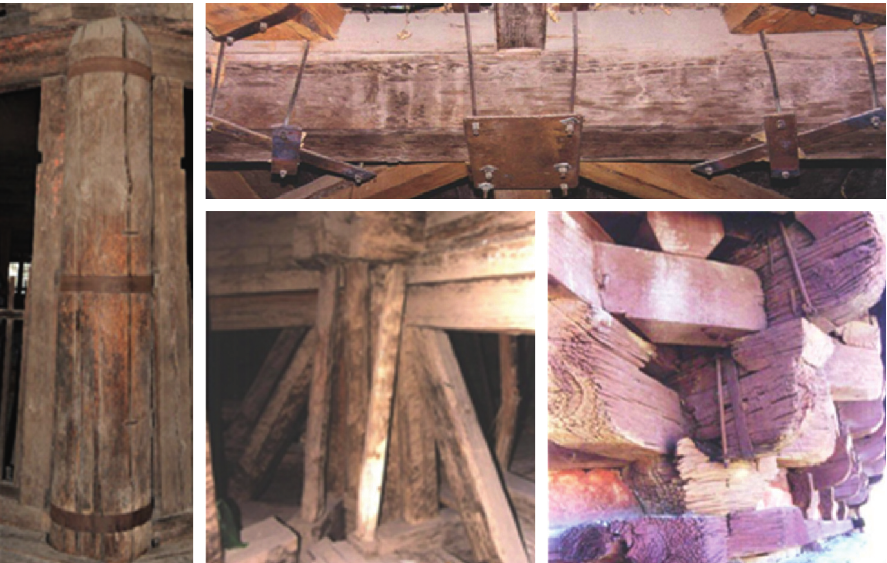
Figure 10: Partial reinforcement conducted on different components of Yingxian Wood Pagoda over the years, such as columns, beams, and Dou-Gong